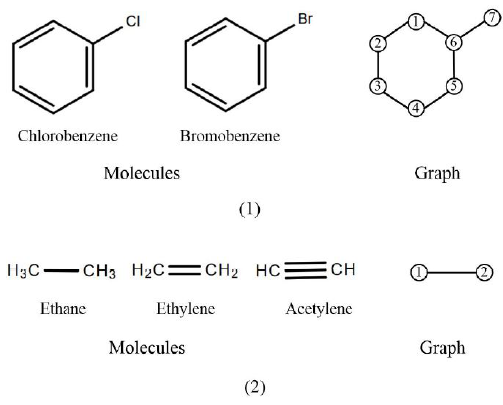
Figure 5. Cases where the degeneracy of the IRA index would